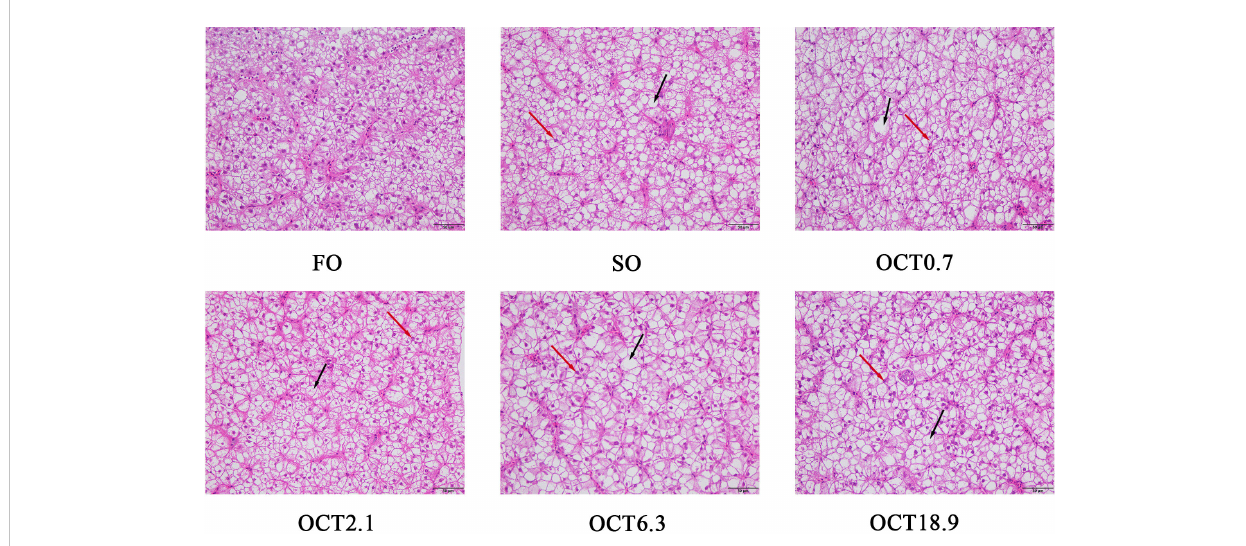
FIGURE 1 Effects of supplemental octanoate on hepatic morphology of large yellow croaker. The H & E staining results of different dietary treatments (200×, bars = 50 µm). The black arrows point to cellular vacuoles and the red arrows point to nuclear